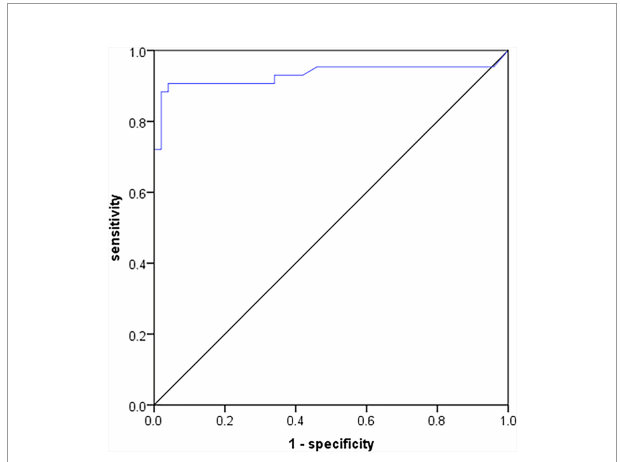
FIGURE 5 | ROC of SUVmax in 68 Ga-P15-041 PET/CT to discriminate bone metastases from benign